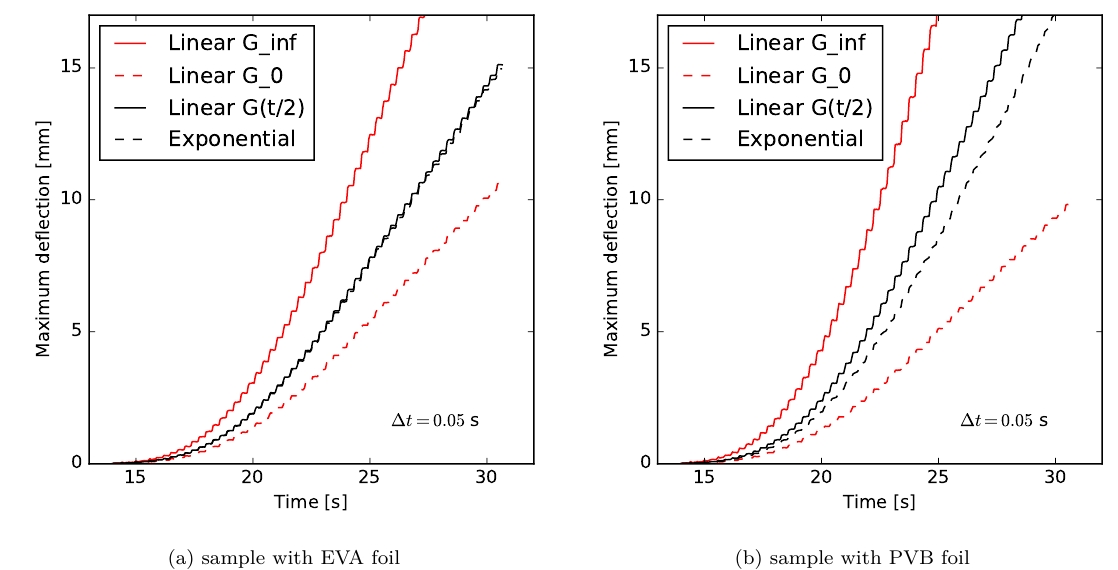
Figure 8. Comparison of the viscoelastic response of laminated glass samples obtained by the exponential algorithm with the elastics ones with three different shear moduli of interlayer assumed.